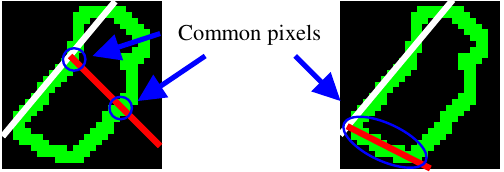
Figure 8: Example of 2 nd longenst matched line search Until the two terminated nodes on the longest lines get same coordinate, this operation repeats. This method can extract line polygons with simple edge images. However this method can’t extract line polygons perfectly with edge images with complex shape. We are now improving the algorithm to extract line polygons precisely.